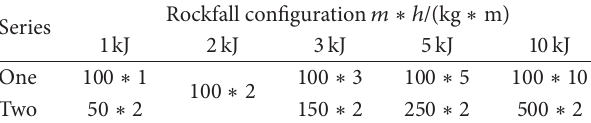
Table 6: Maximum impact force of slab without cushion layer. Series